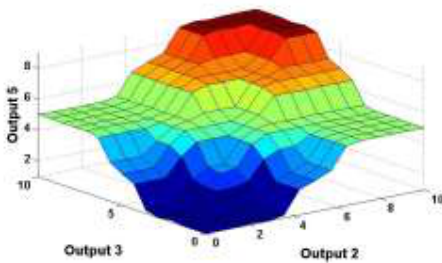
Figure 15. Surfaces of the fuzzy logic subsystem 5.